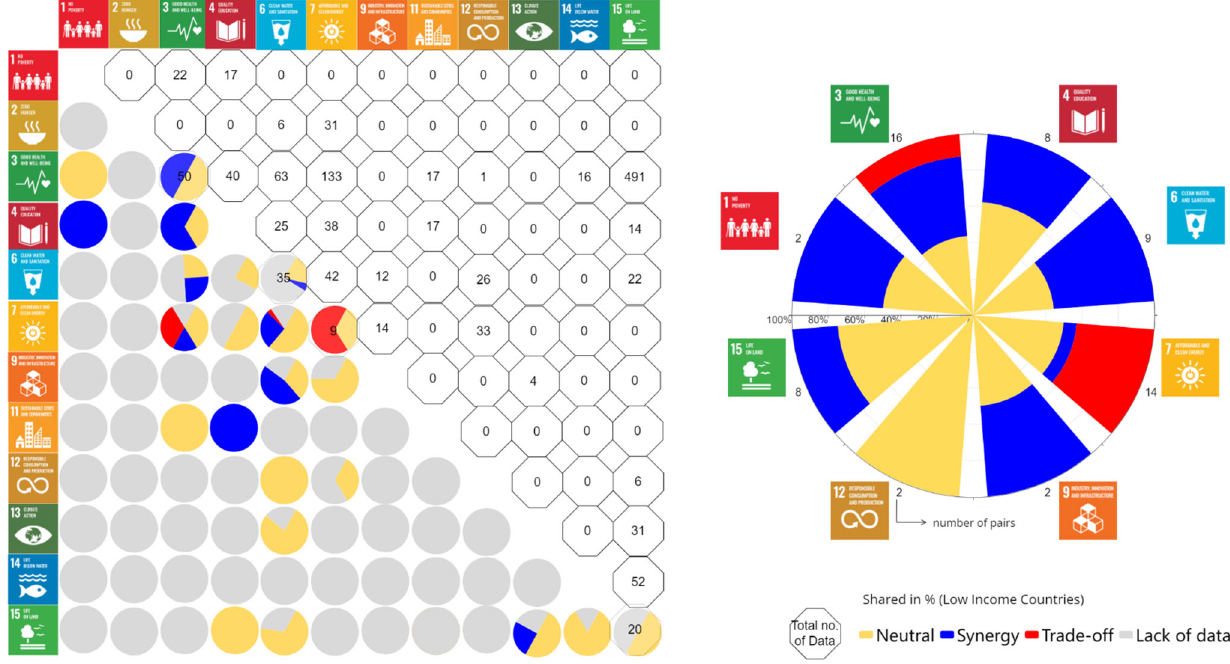
Figure 4. Matrix of interlinkage percentage with number of samples ( left ) and shares in percentage of interlinkage with total number pairs in LIC ( right ).